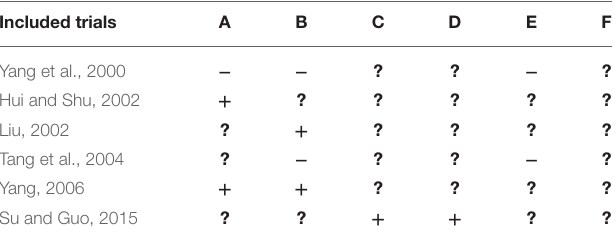
TABLE 3 | Methodological quality of included studies based on the Cochrane handbook. Included